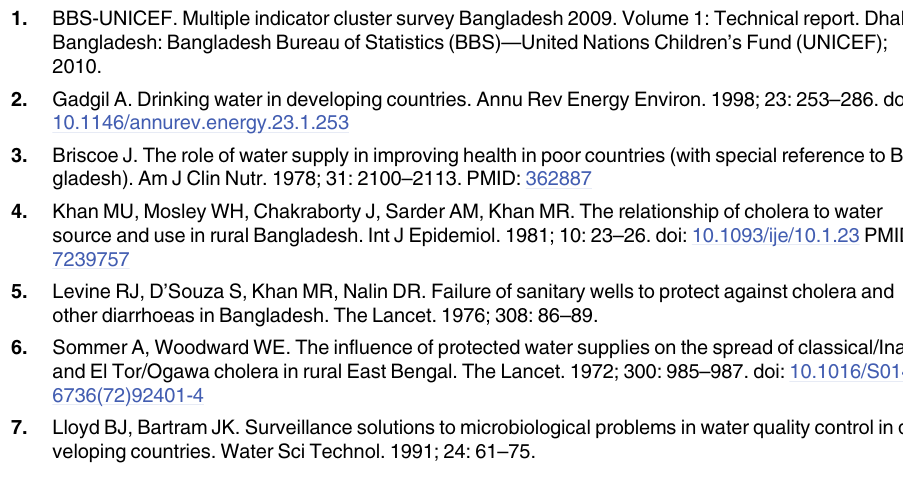
S8 Table. Prevalence of negative control outcomes across study arms (2-day and 7-day re- call period) among children 8 – 32 mo of age.